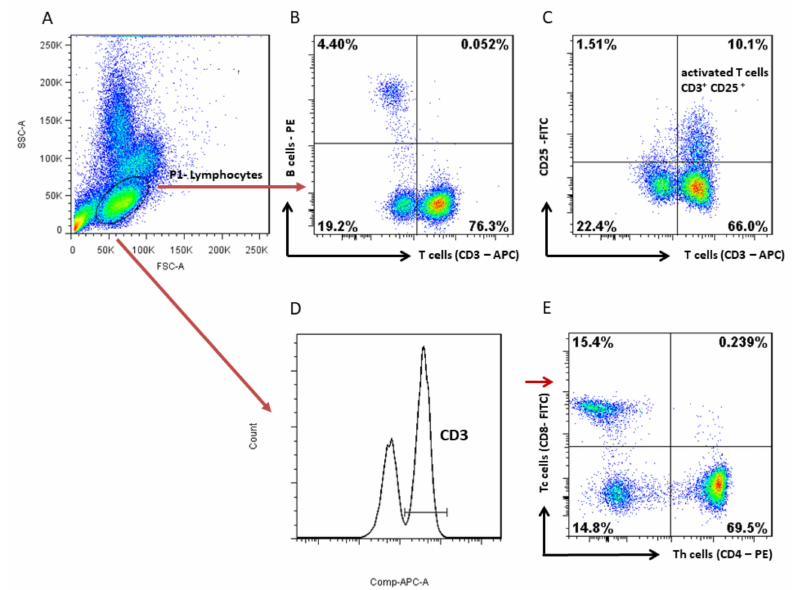
Figure 1. Representative plots of gating strategy for flow cytometry showing canine lymphocyte subpopulations. ( A ) Forward-scatter area (FS) versus side-scatter area (SS) plot to delineate the lymphocyte region. ( B ) B cells and T cells (CD3 + ) were gated among lymphocytes. ( C ) CD25 versus CD3 plot was used to gate activated T cells (CD3 + CD25 + ) among lymphocytes. ( D ) Representative histogram of CD3 + cells, ( E ) among which Th cells (CD3 + CD4 + ) and Tc cells (CD3 + CD8 + ) were detected on CD4 versus CD8 plot. Data were analyzed using FlowJo